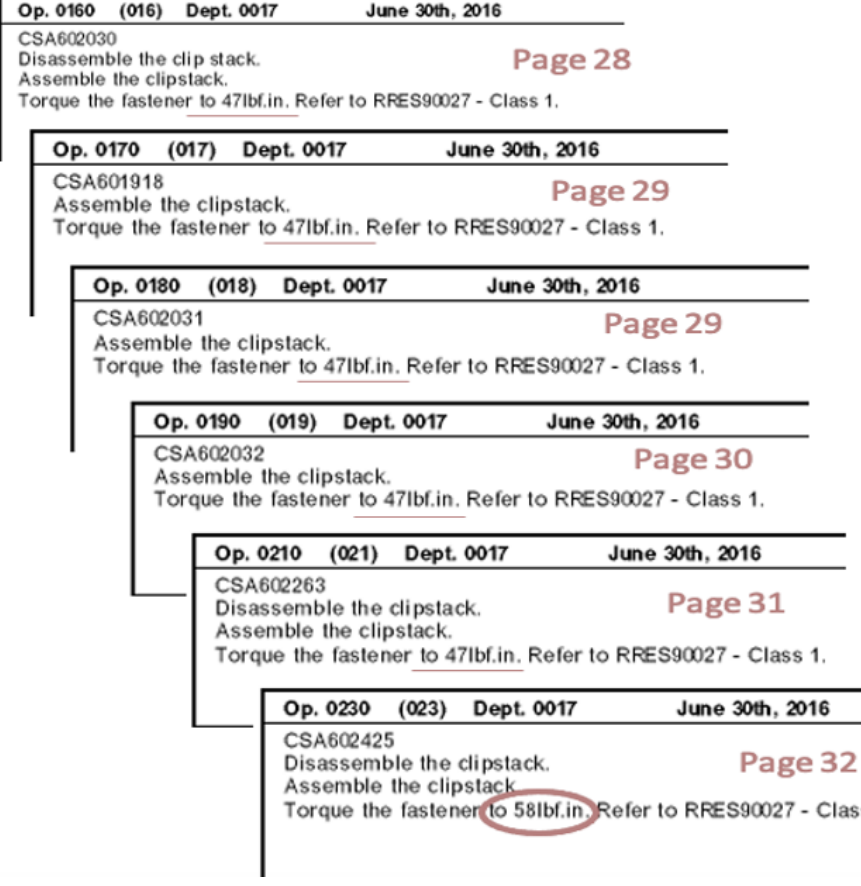
Figure 6. Marked bolt (red φ 9).